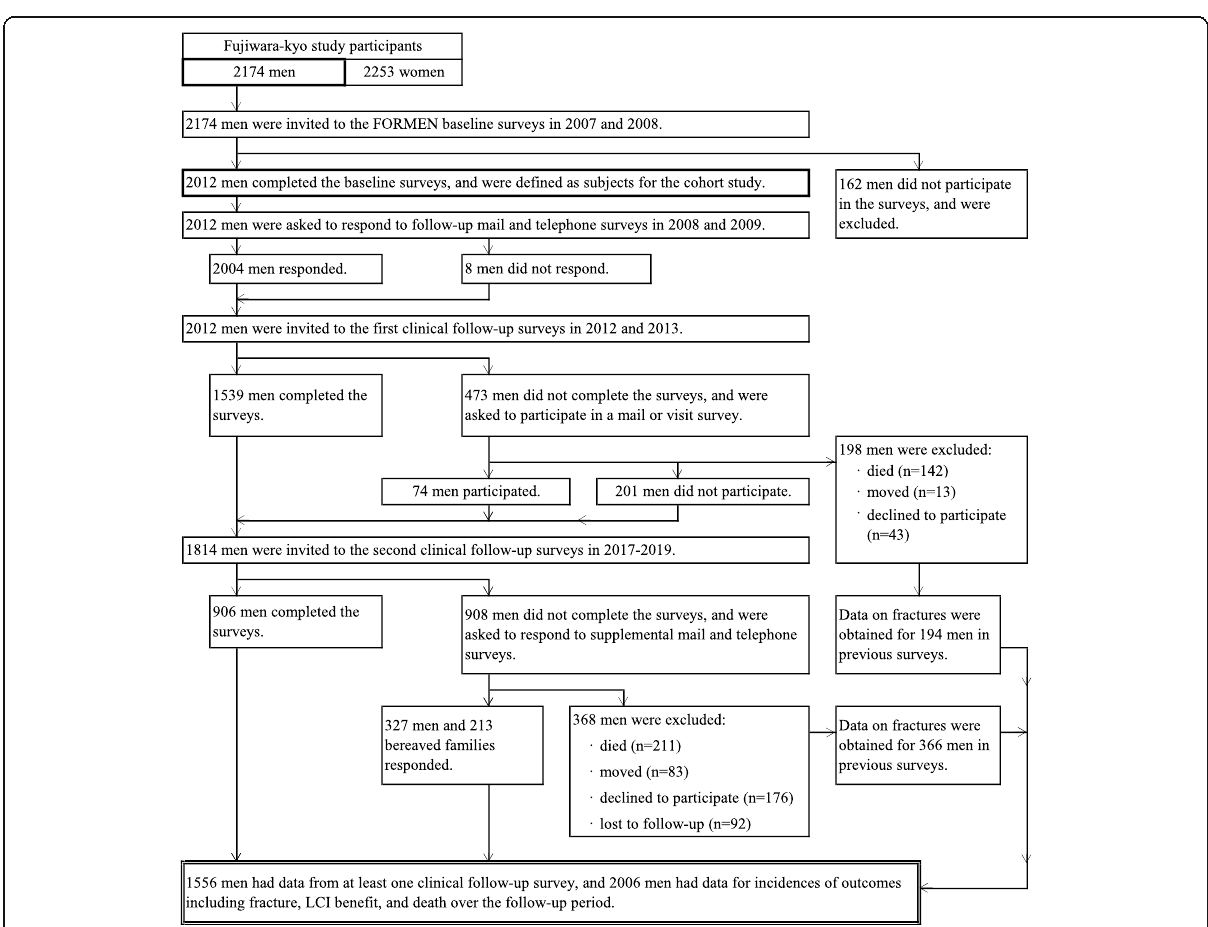
Fig. 1 Flow diagram of participant selection in the FORMEN